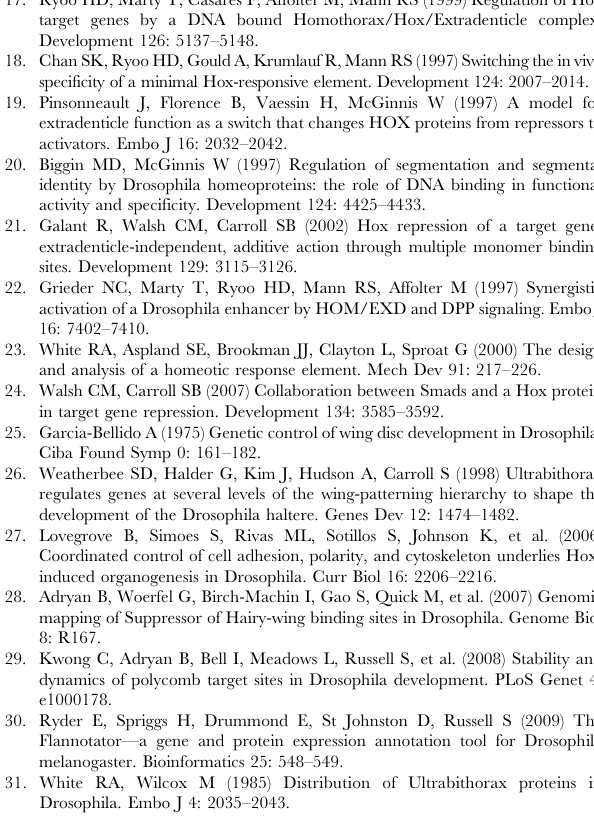
Table S2 Ubx-bound genes (1% FDR haltere data).